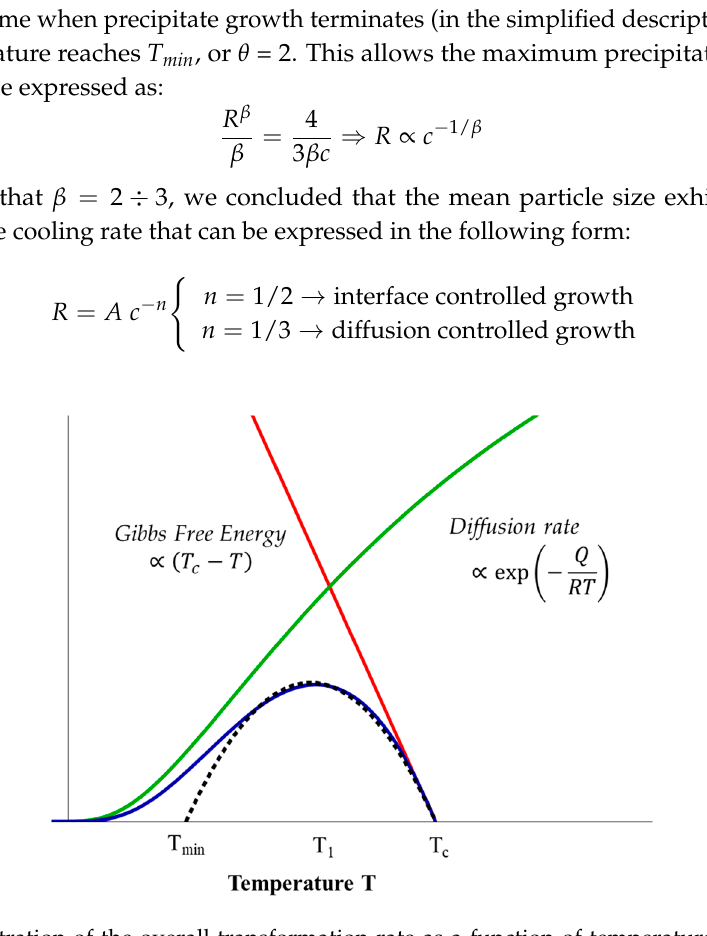
Figure 5. Illustration of the overall transformation rate as a function of temperature. The dashed line illustrates the parabolic approximation for the temperature dependence of the rate of the overall transformation. T min : Assumed to be the minimum temperature below which the diffusivity is too slow for the transformation. T 1 : Critical temperature for maximum overall transformation rate. T c : Equilibrium transformation temperature for nucleation.